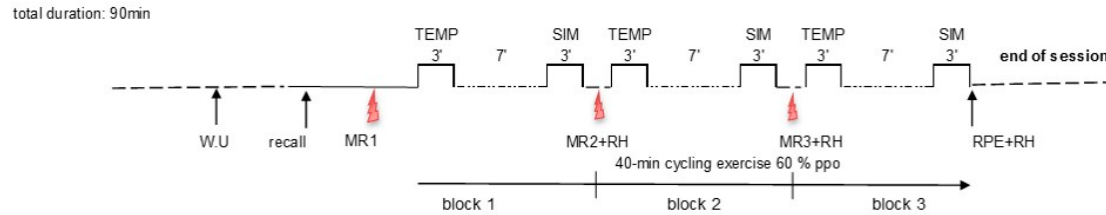
Figure 1. General procedure of each experimental session. (WU = Warm Up; Recall = Cognitive tasks recall; TEMP = Duration Production task; SIM = Simon task; MR = mouth rinsing; RH = Rehydration; ppo = peak power output; RPE = Rating of Perceived Exertion).